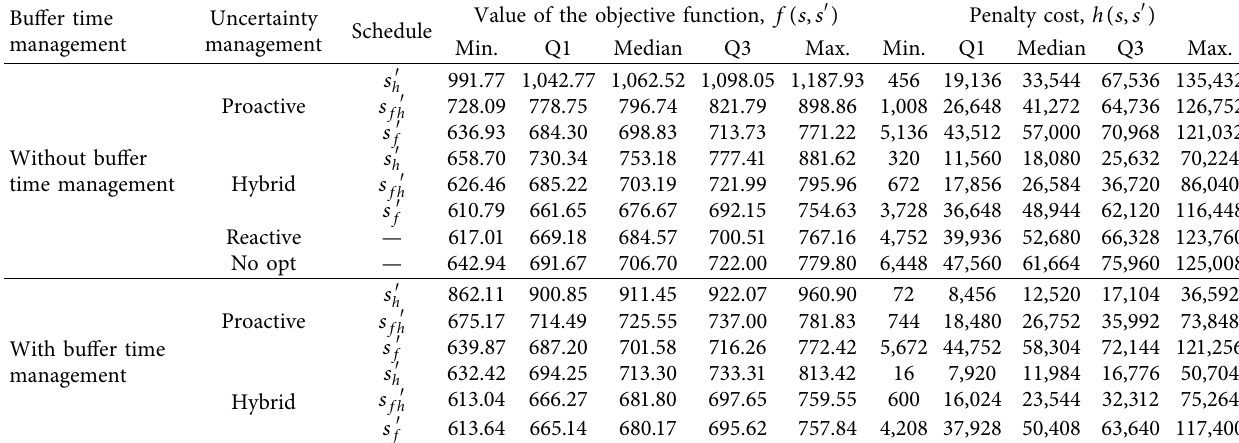
Table 3: Performance comparison between proactive, reactive, and hybrid solution approaches.